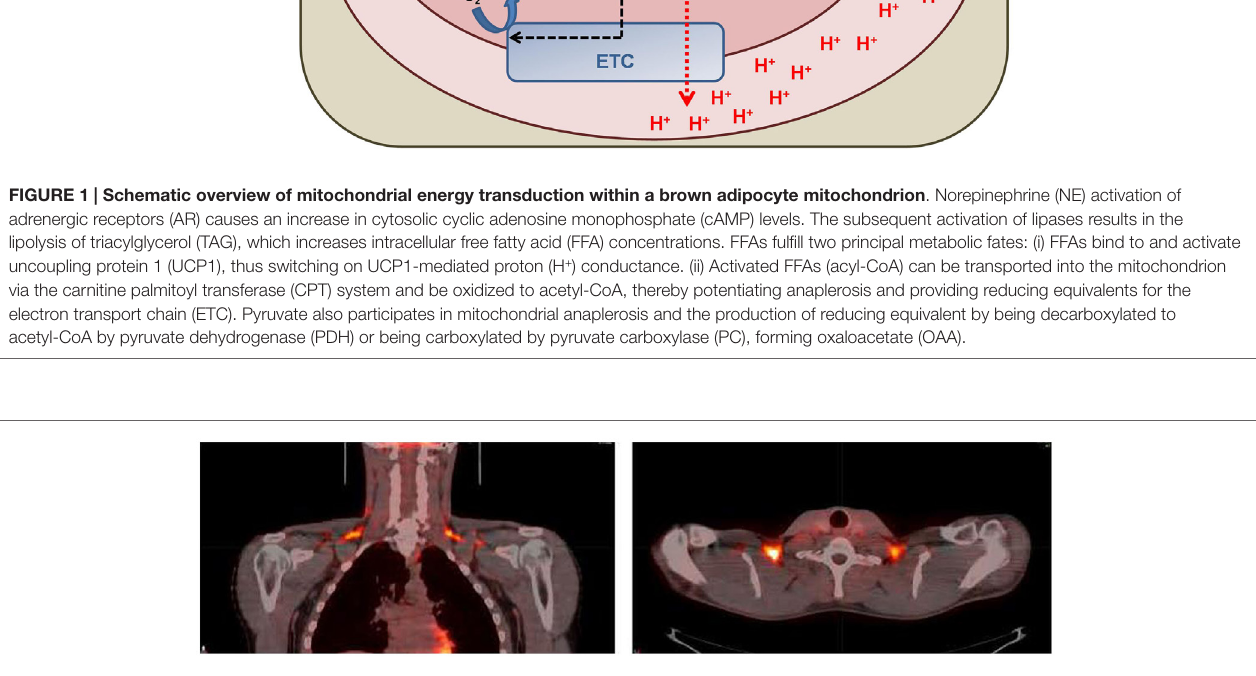
FiGURe 2 | Coronal (left) and transverse (right) 2-deoxy-2-[18F]fluoro- d -glucose ( 18 F-FDG) positron emission tomography (PeT)-computed tomography (CT) images from a volunteer during cold exposure . The intense orange color in the supraclavicular area corresponds to brown adipose tissue. Image from Ref. (24). Reprinted with permission.